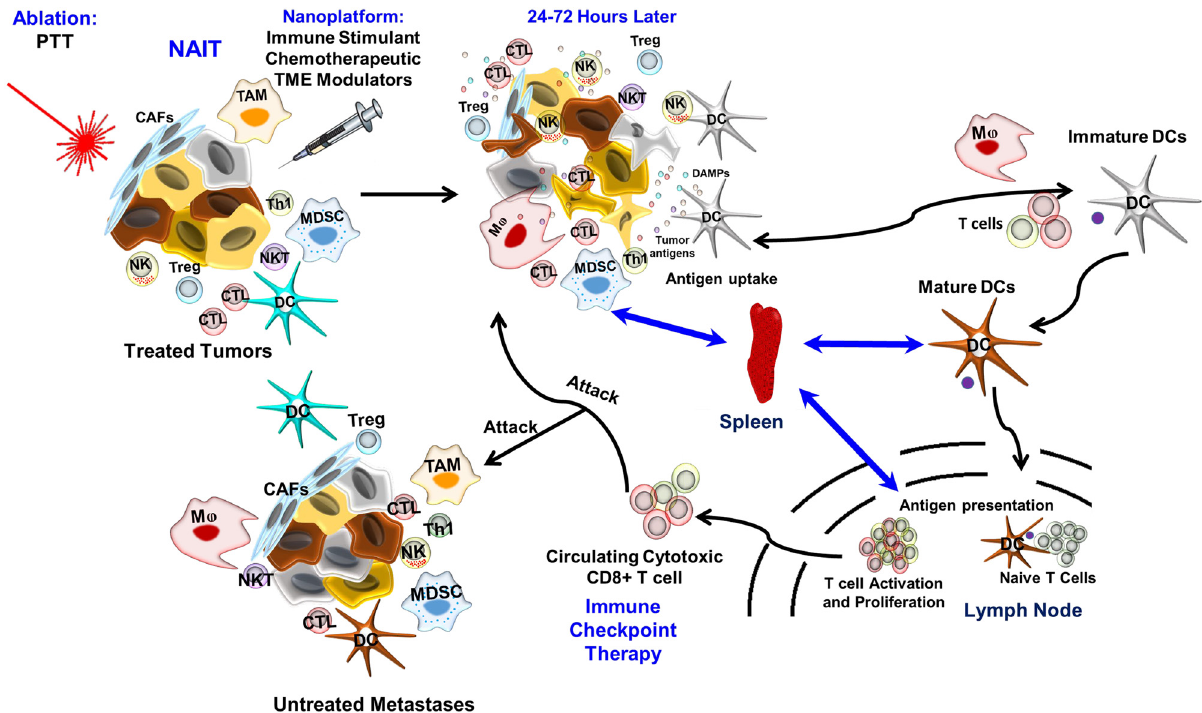
Figure 1: Illustration of nano-ablative-immunotherapy (NAIT) for the treatment of primary and metastatic tumors, through spatiotemporally coordinated immune responses and immune checkpoint